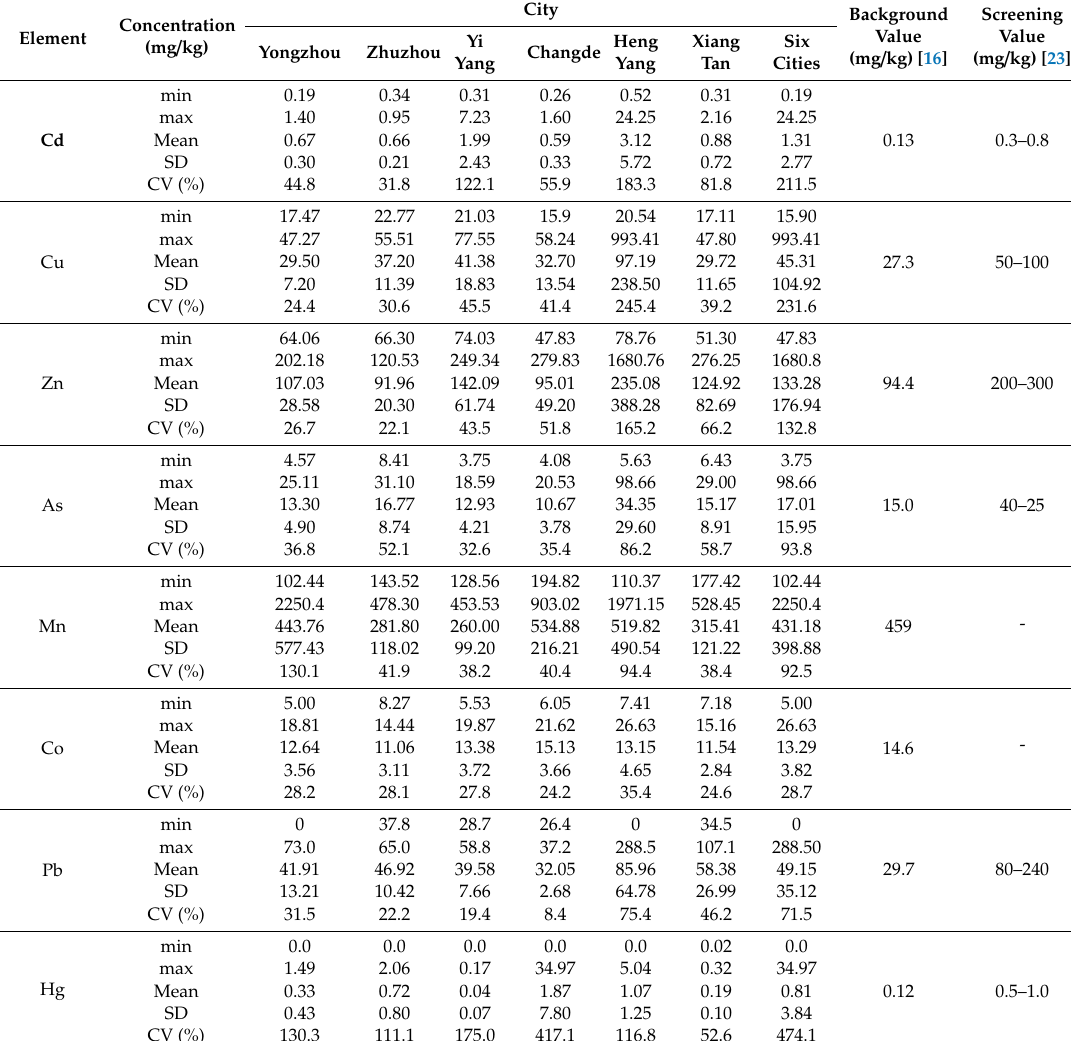
Table 1. Descriptive statistics of potentially toxic elements (PTEs) concentrations in the surface and sub-surface soils (mg /